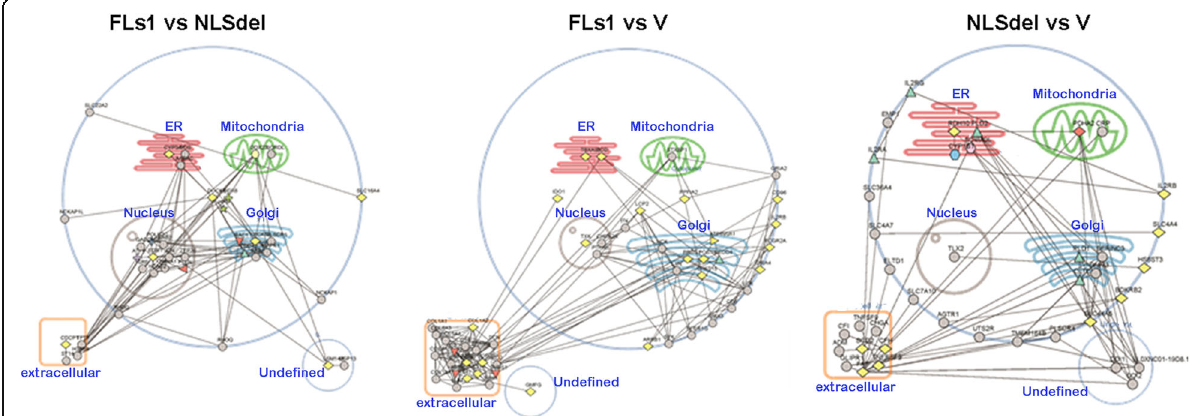
Fig. 7 Subcellular localization of gene products regulated by the different constructs. Left: Comparison between the full-length syndecan-1 (FLs1) and the syndecan-1 lacking the nuclear localization signal (NLSdel) showed that most differentially expressed genes were localized to the nucleus. Middle: Comparison between FLs1 and the empty vector control (V) shows differentially expressed genes that code for membrane-bound proteins or proteins located to the extracellular matrix. Right: Comparison between the NLSdel and empty vector control (V) showed that most of the differentially expressed genes pertained to regulation of proteins in the cell membrane and extracellular